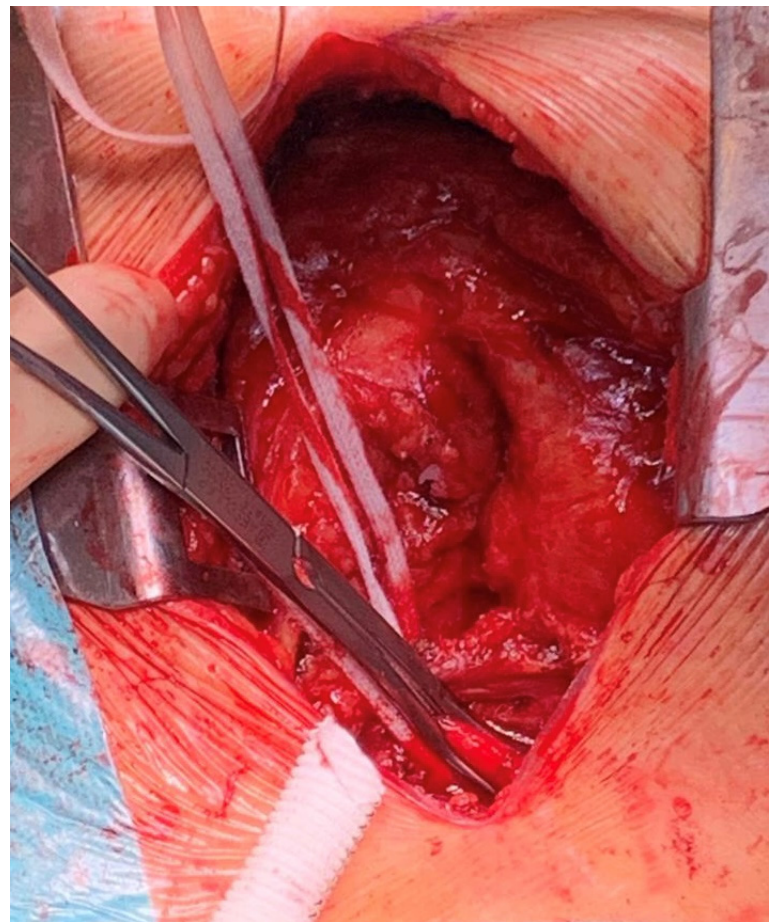
Figure 2. Exposure of the innominate artery and partial clamping for vascular graft anastomosis.